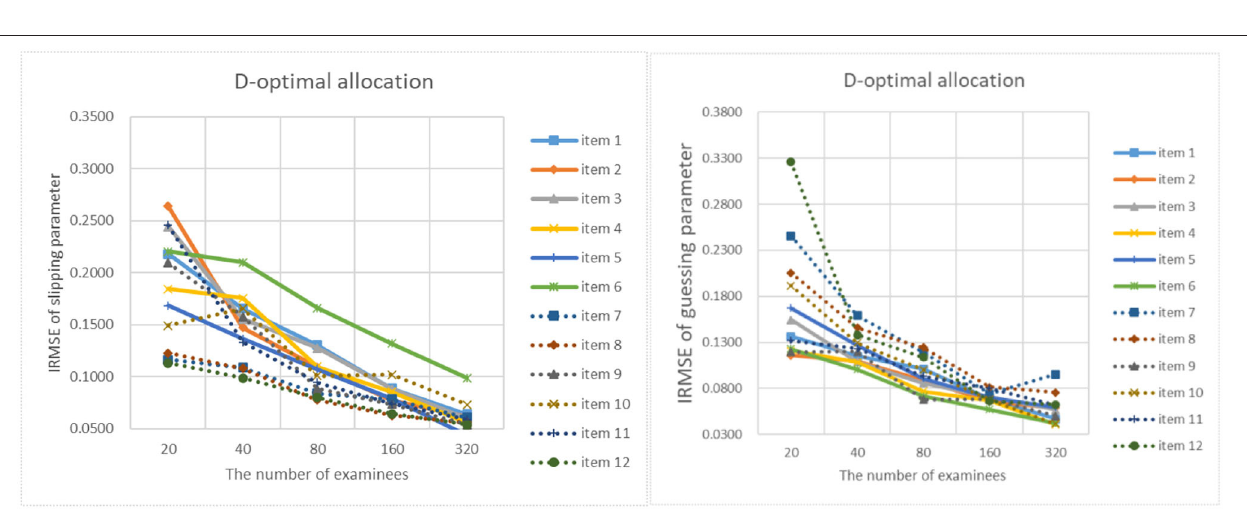
FIGURE 9 | The RMSE of each item parameter of the D-optimal allocation strategy when the initial value of the item parameter is 0.05.